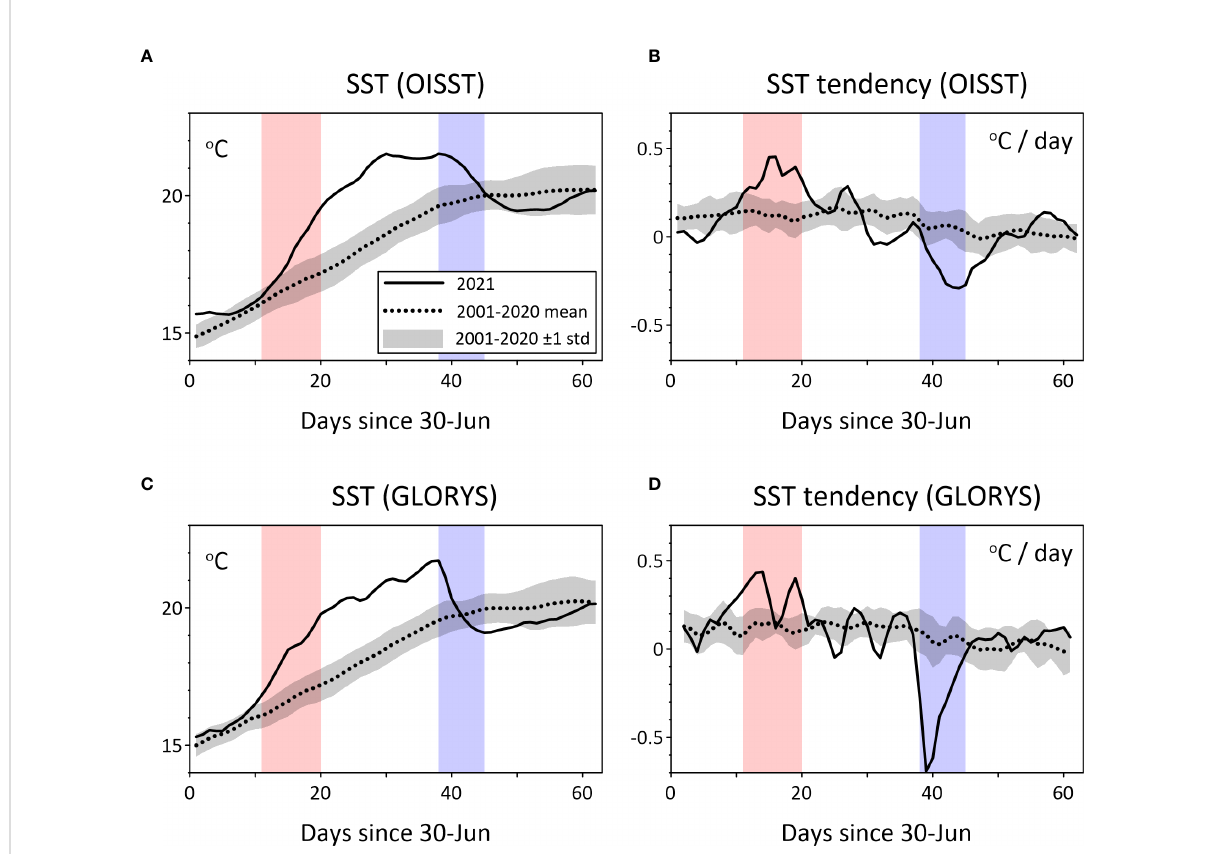
FIGURE 2 Time series plots of (A, C) sea surface temperature (SST) and (B, D) SST tendency in the total (TOT) mid-latitude in the western North Paci fi c region for 2021 (solid line), climatology for 2001 – 2020 (dotted line), and its typical interannual variability estimated using one standard deviation (gray shading) from the (A, B) OISST and (C, D) GLORYS. The periods of rapid warming and cooling are indicated by red and blue shadings,